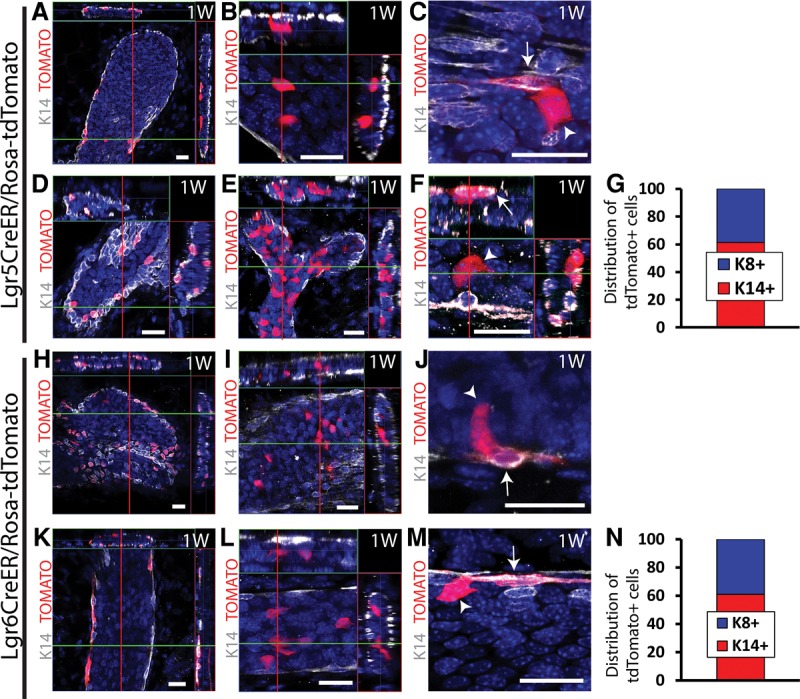
Colabeling of BCs and LCs by Lgr5 and Lgr6CreER in the MG. (A–F) Confocal imaging of immunostaining of K14 and Tomato 1 wk after TAM administration to Lgr5-EGFP-IRES-CreERT2/Rosa-tdTomato pubertal (15 mg) (A–C) or adult virgin (1.5 mg) (D,E) mice. (A,D) Isolated BCs. (B,E) Isolated LCs. (C,F) Doublets of BCs and LCs. In adult mice, doublets could be observed only at high doses of TAM (15 mg). (G) Distribution of basal K14+ and luminal K8+ cells among Tomato+ cells (2865 cells out of three mice). (H–M) Confocal imaging of immunostaining of K14 and Tomato cells 1 wk after TAM administration (15 mg) to Lgr6-EGFP-IRES-CreERT2/Rosa-tdTomato pubertal (H–J) or adult virgin (K–M) mice. (H,K) Isolated BCs. (I,L) Isolated LCs. (J,M) Doublets of BCs and LCs. (N) Distribution of basal K14+ and luminal K8+ cells among Tomato+ cells (4683 cells out of three mice). Arrows depict BCs, and arrowheads depict LCs. (A,B,D–F,H,I,K,L) Orthogonal projections of three-dimensional (3D) stacks. (C,J,M) Single-plane images from a 3D stack. Bars, 20 µm. Histograms represent the mean. See Supplemental Table S1 for further information on the statistics.